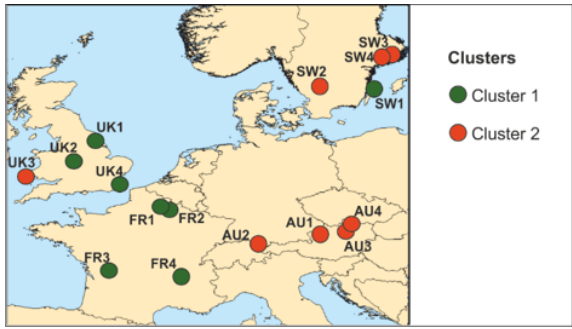
Figure 5. Geographical distribution of determined clusters. Map image is the intellectual property of Esri and is used herein